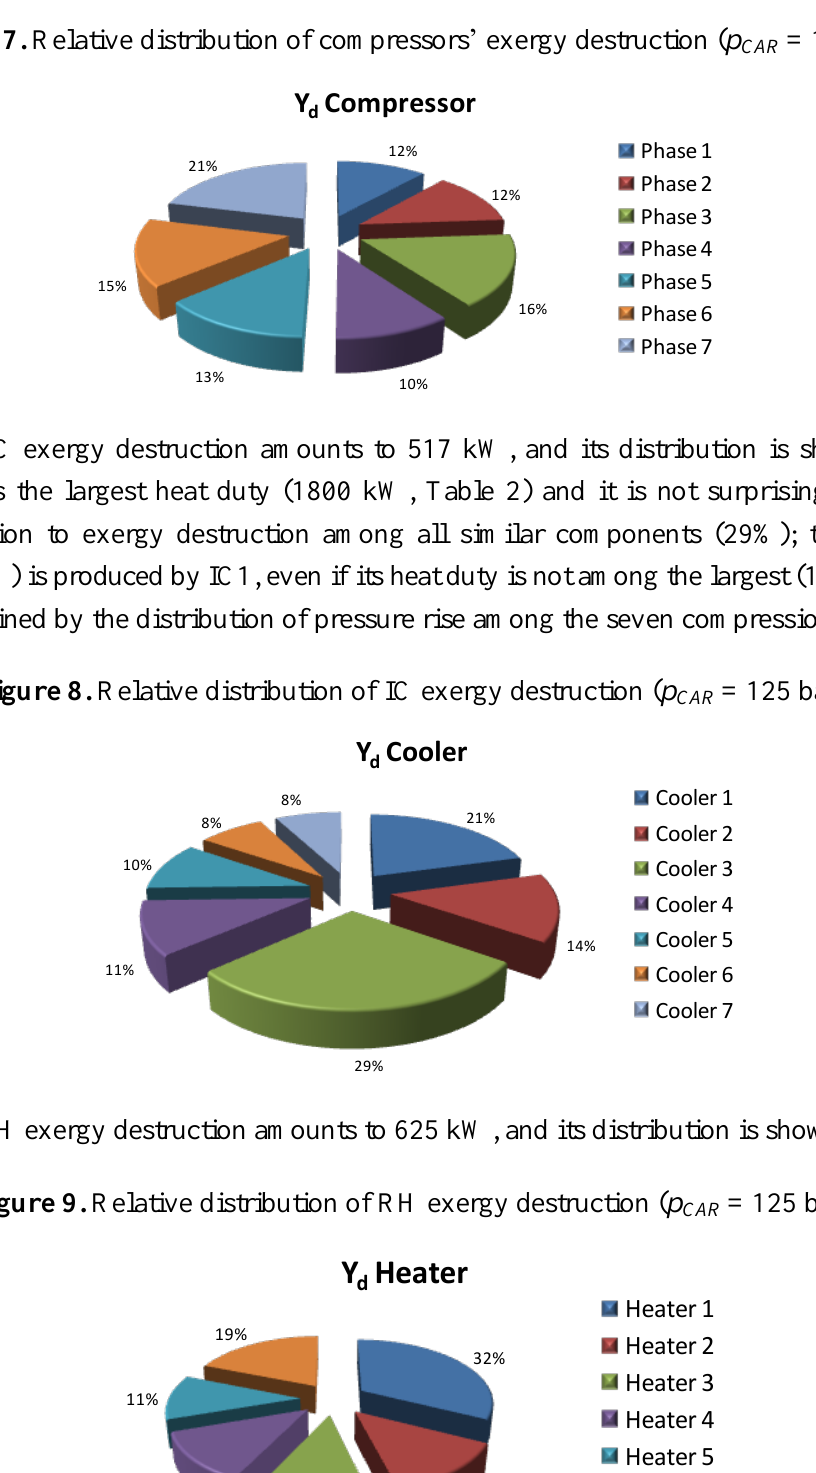
Figure 7. Relative distribution of compressors’ exergy destruction ( p